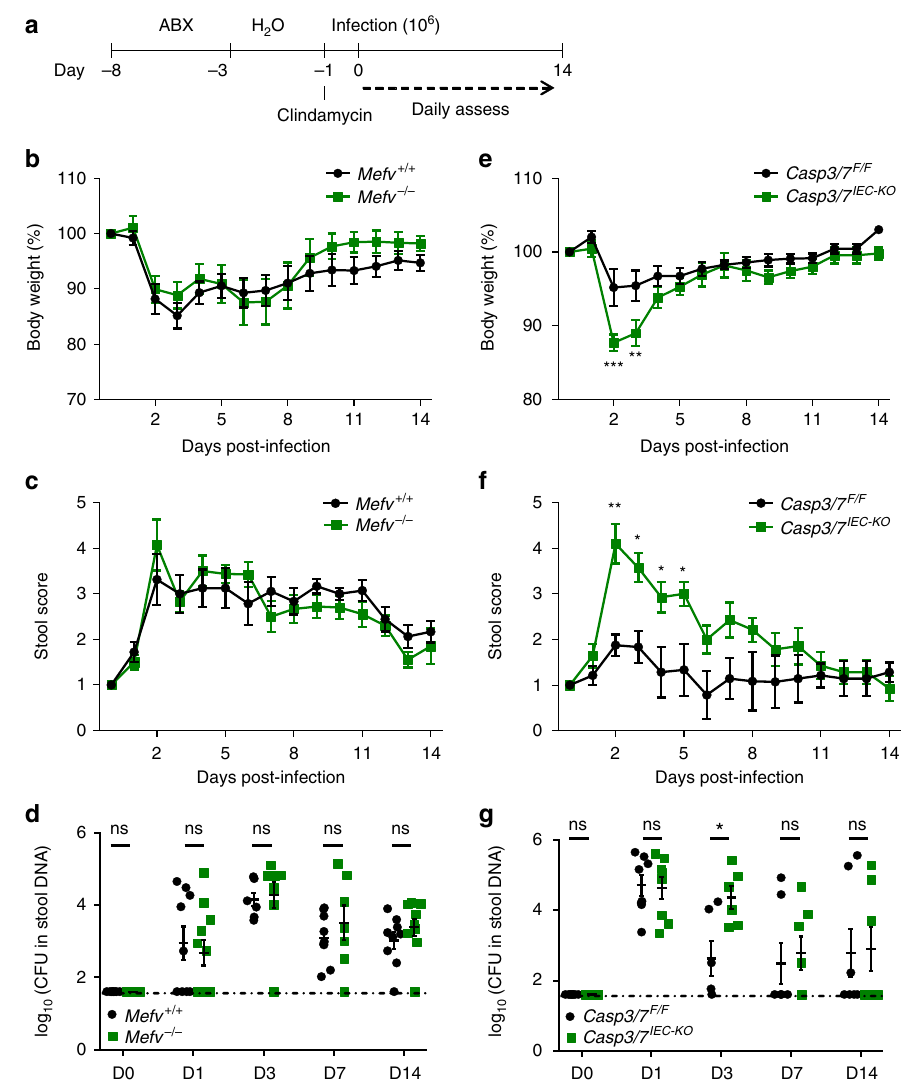
Fig. 5 IEC apoptosis protects mice during in vivo C. dif fi cile infection. a Scheme of C. dif fi cile infection protocol. b – d Mefv + / + ( n = 9) and Mefv − / − ( n = 11) littermates mice were infected with C. dif fi cile and monitored for body weight ( b ), stool score ( c ) and bacterial burden in the stool ( d ). e – g Casp3/7 F/F ( n = 7) and Casp3/7 IEC-KO ( n = 7) littermates mice were infected with C. dif fi cile and monitored for body weight ( e ), stool score ( f ) and bacterial burden in the stool ( g ). Nonparametric Mann – Whitney U test was used to analyze the data. Error bars represent SD. * P < 0.05, ** P < 0.01, and *** P <